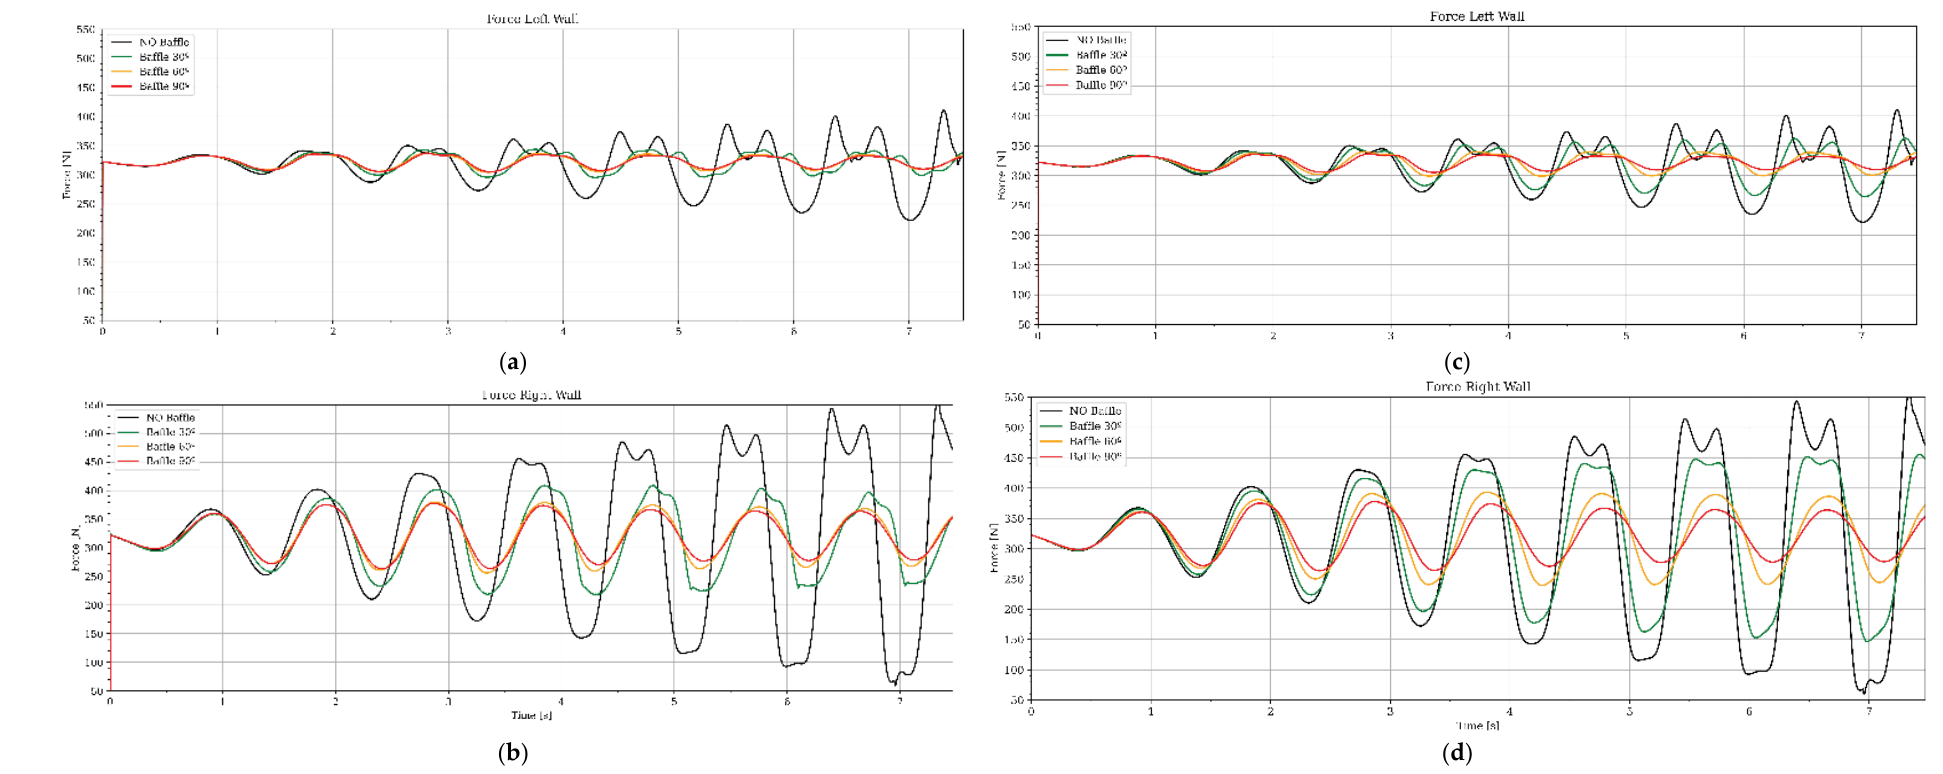
Figure 10. Forces for left column for fixed H b = 75 mm for ( a ) left wall, ( b ) right wall and right column for fixed L b = 75 mm for ( c ) left wall, ( d ) right wall.